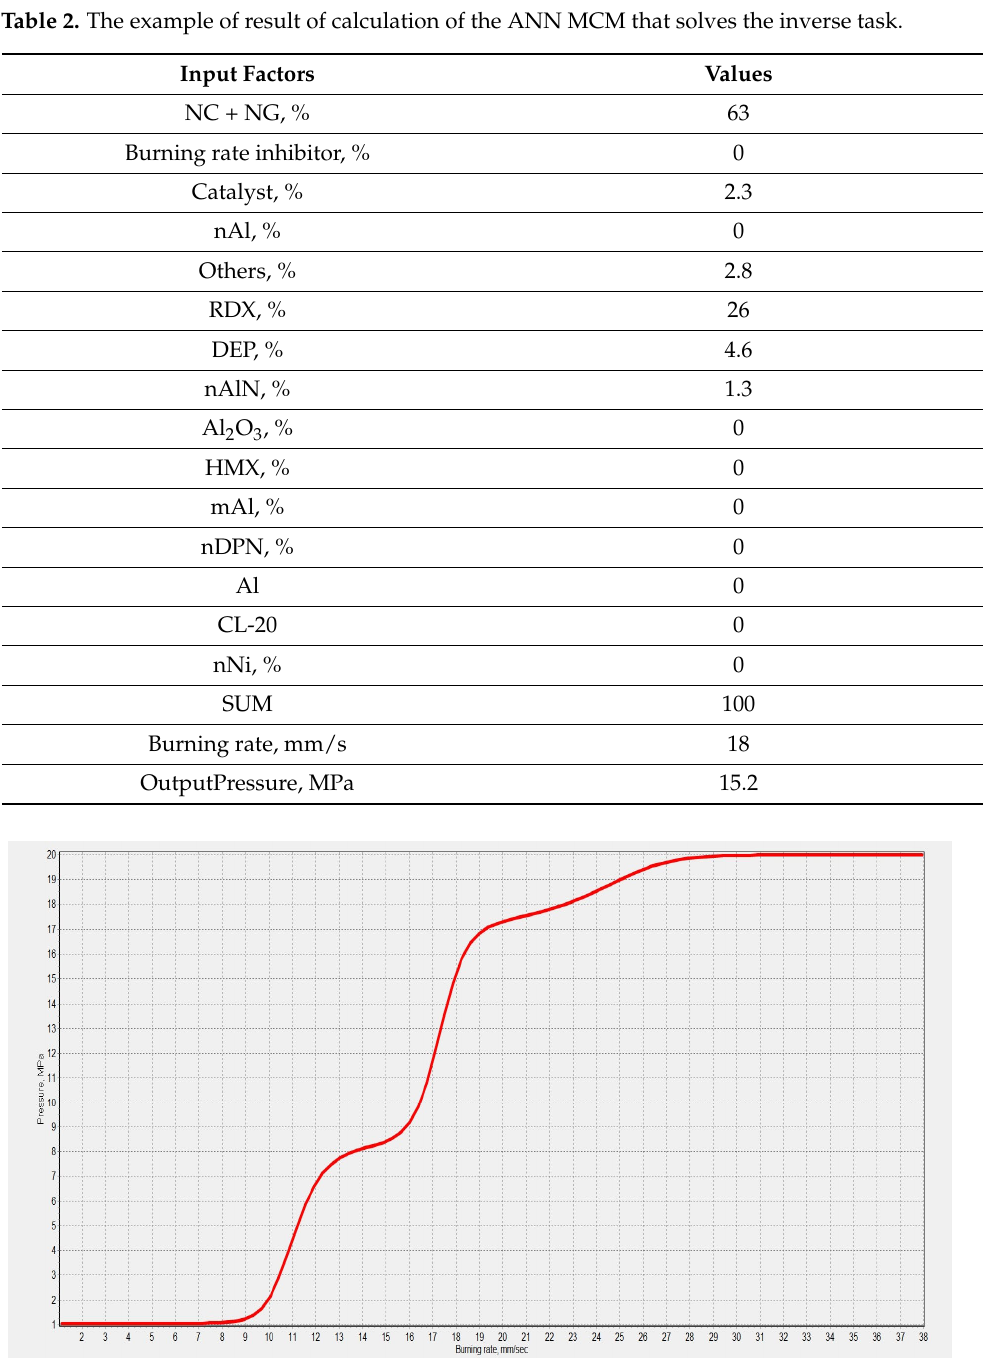
Figure 7. An example of a graph of connection of burning rate and pressure. The graph is valid only for the set of input factors values indicated in Table 2. For other sets of values, the graphs will be different. Table 2. The example of result of calculation of the ANN MCM that solves the inverse task.